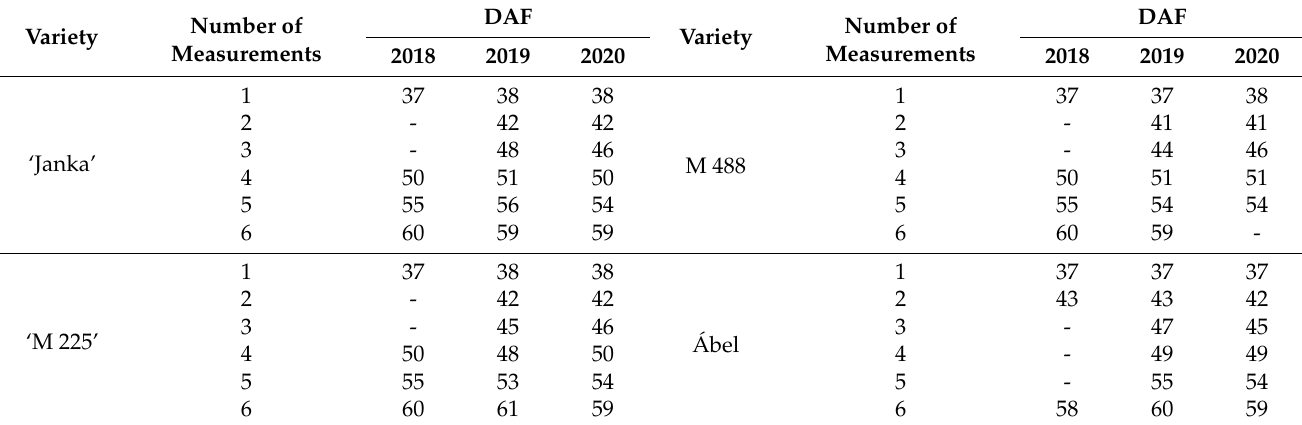
Table 1. Schedule of threshability measurements based on the number of days after flowering